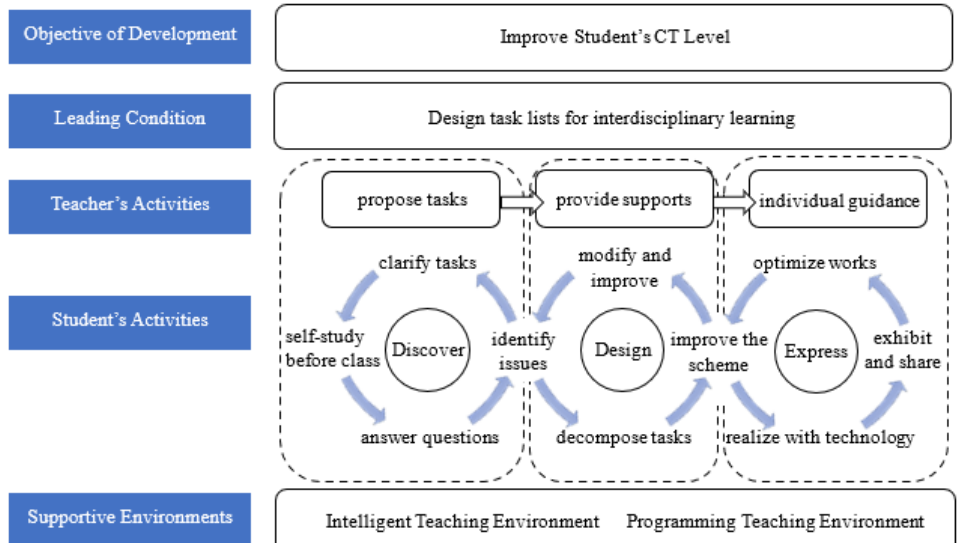
Figure 1. Our interdisciplinary activity design for the development of